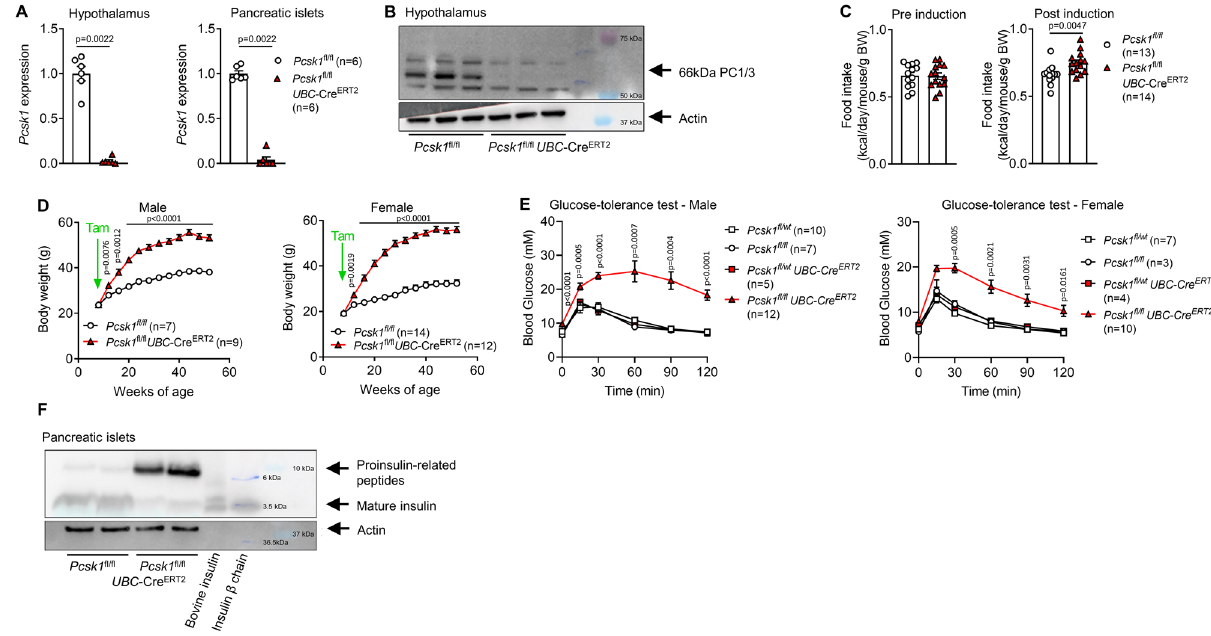
Fig. 1 | Induced whole-body PC1/3 deletion leads to pronounced hyperphagic obesity. A Normalized Pcsk1 expression in the hypothalamus and pancreatic islets isolated from 12-week-old mice 4 weeks after knockout induction. B PC1/3 protein expression in hypothalami isolated from 14-week-old mice 5 weeks after knockout induction. Note: signal at 55kDa is unrelated to PC1/3 and known to appear in this batch of antibody. C Food intake pre (from 7 to 8 weeks of age) and post (10 – 11weeksofage)inductionat8weeksofage.Eachdotrepresentstheaverageof a cage with 2 – 3 mice. D Body weight development. E Circulating glucose con- centration after injection of 2gkg − 1 glucose at 12 weeks of age 4 weeks post